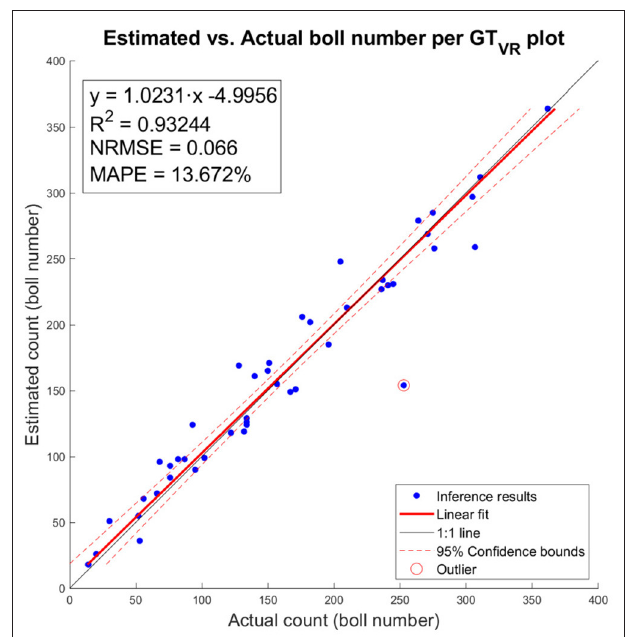
FIGURE 10 | Estimated vs. actual number of cotton bolls per ground truth plot (GT VR ). Blue dots represent inference results of our model. Red line represents the linear fit. Red dotted lines represent the 95% confidence interval for the fit. One outlier is marked with a circle surrounding the data